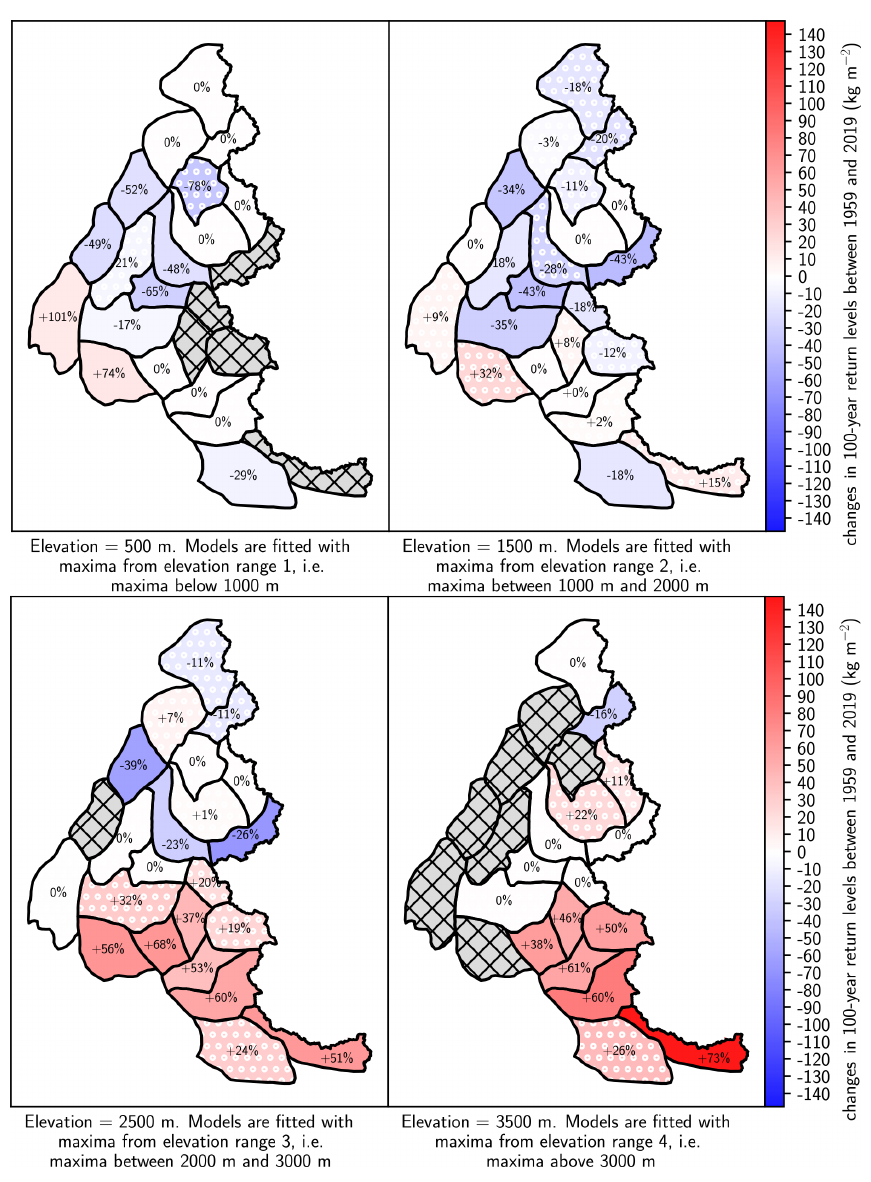
Figure 8. Changes in 100-year return levels of daily snowfall between 1959 and 2019 for each range of elevations. The corresponding relative changes are displayed on the map. Hatched grey areas denote missing data, e.g., when the elevation is above the top elevation of the massif. Changes in return levels are computed at the middle elevation for each range, e.g., at 1500m for the range 1000–2000m. Massifs with non-significant trends are indicated with a pattern of whites